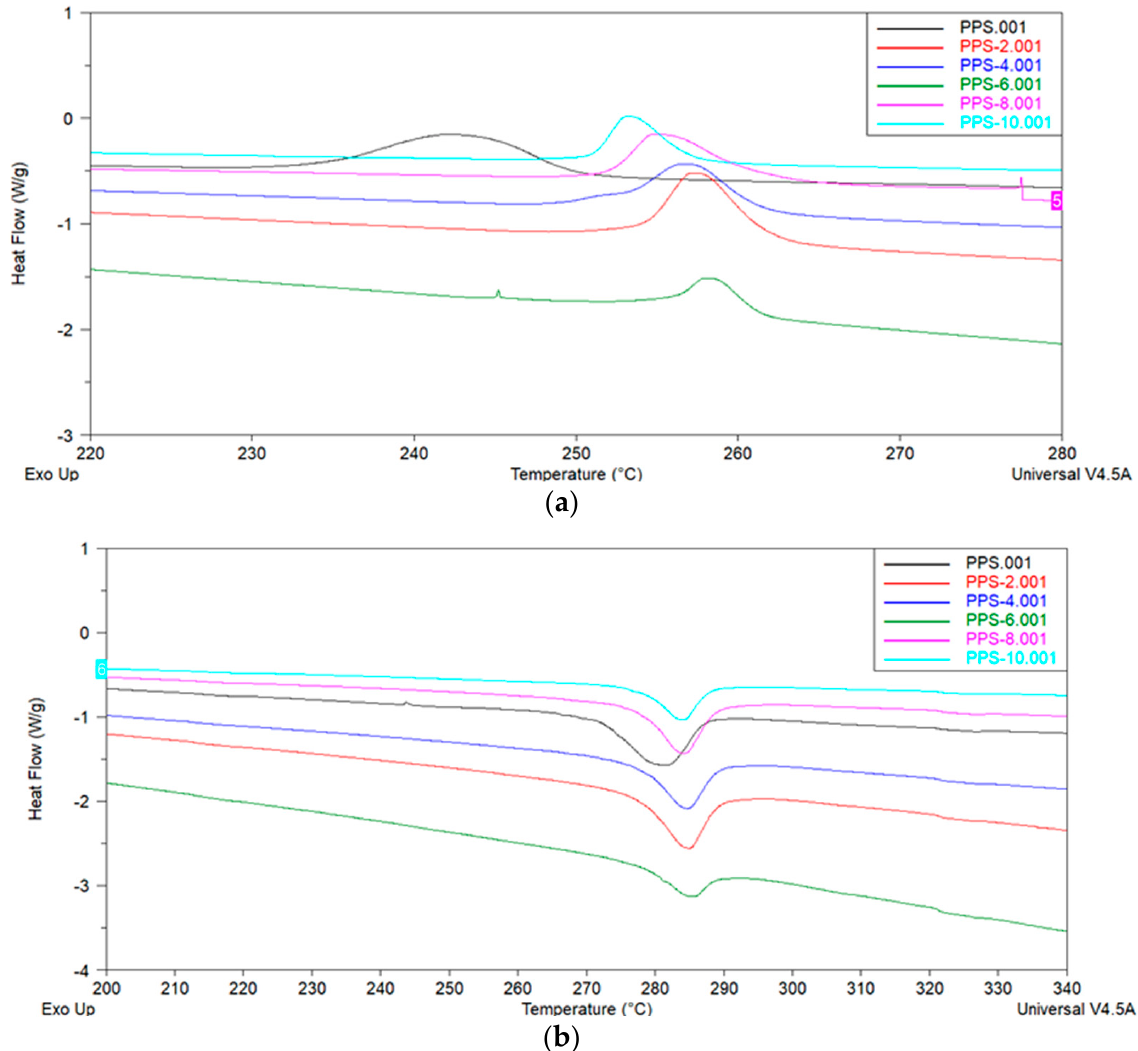
Figure 9. DSC curves of PPS@BC nanocomposites: ( a ) cooling cycle ( b ) heating cycle.